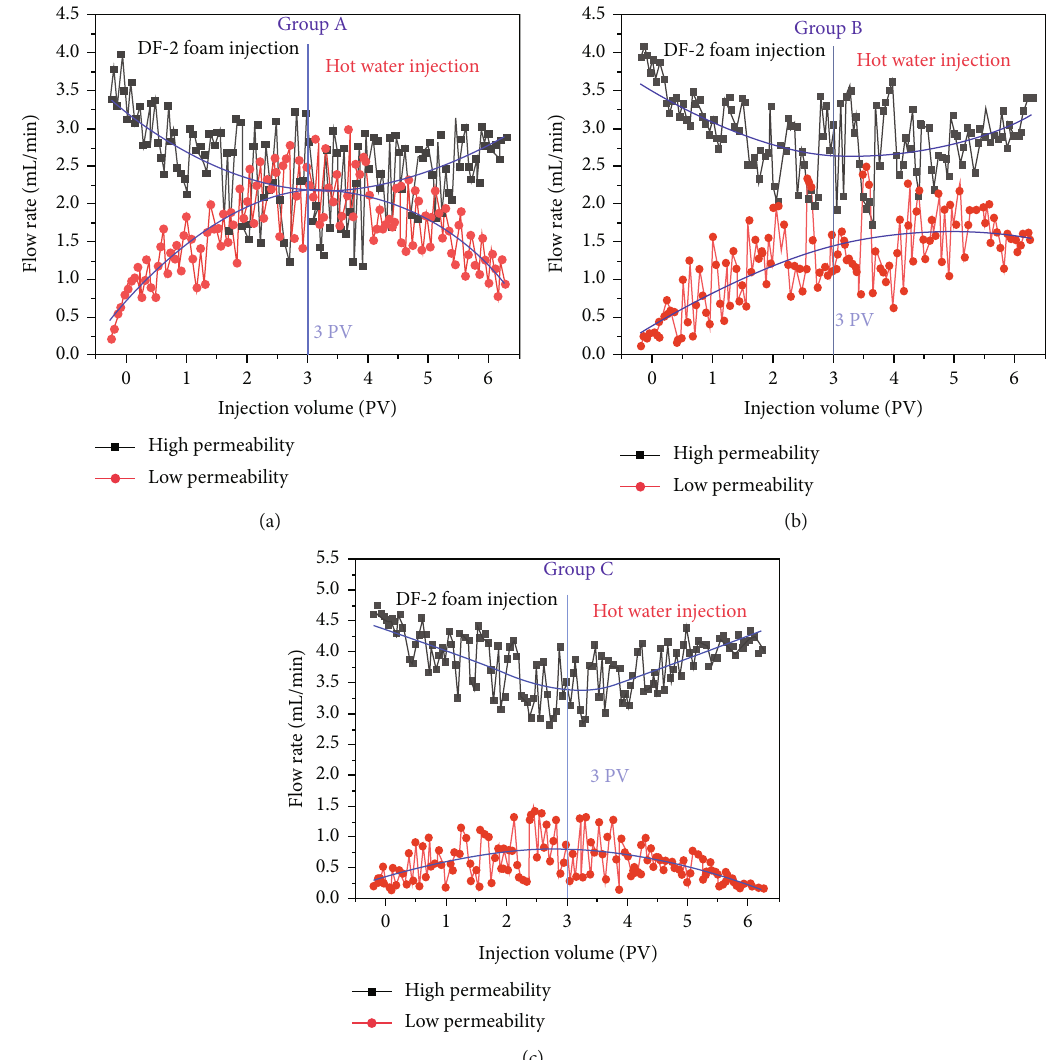
Figure 7: E ff ect of permeability di ff erence on foam partial fl